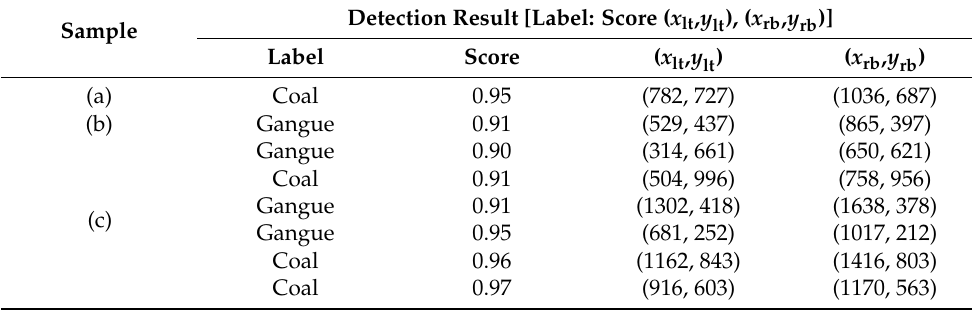
Table 4. Comparison of different lightweight schemes.